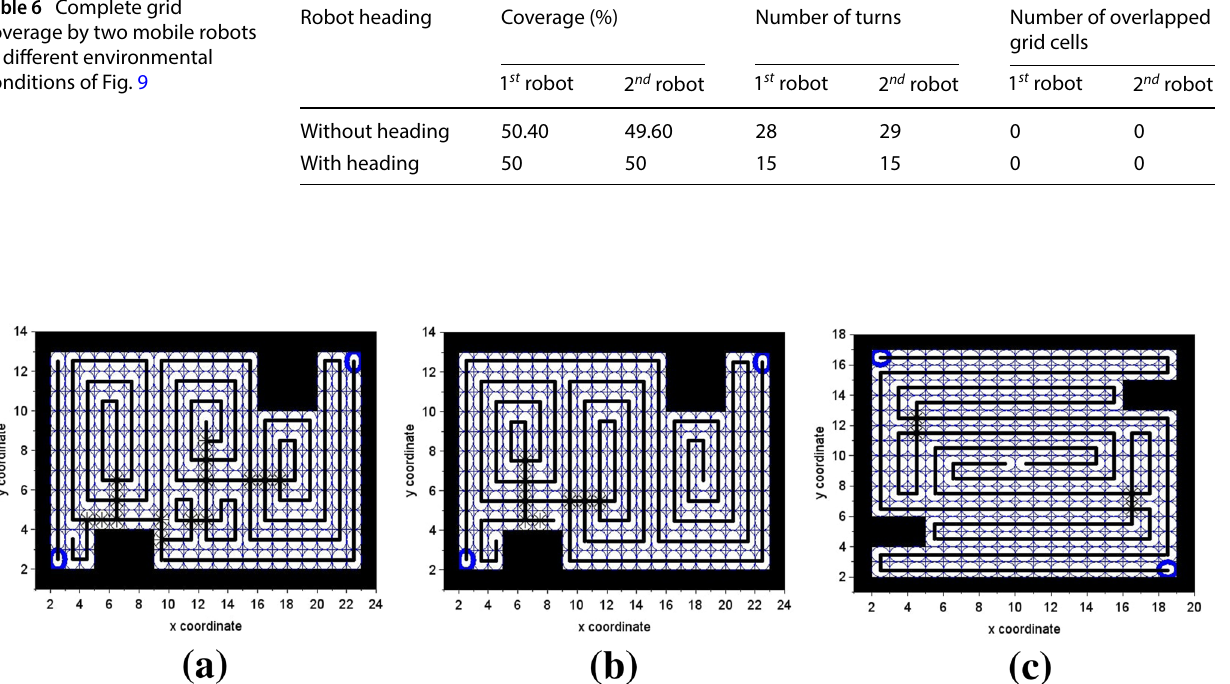
Table 6 Complete grid coverage by two mobile robots in different environmental conditions of Fig. 9